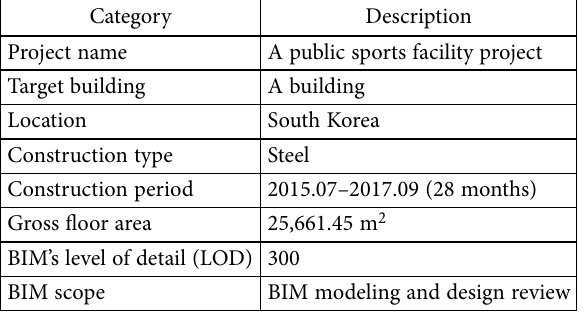
Table 5. Results of BIM contribution level ( c r